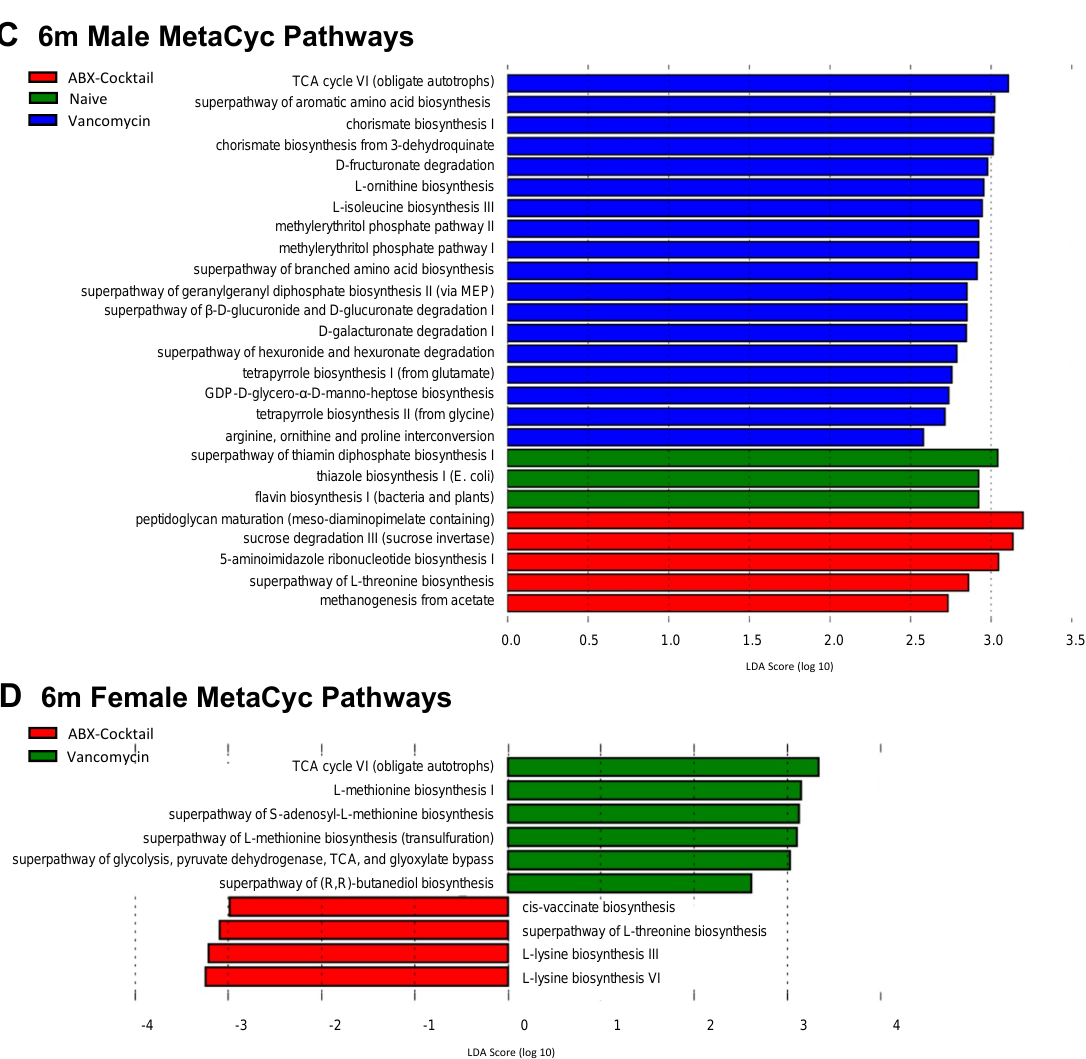
Figure 5. PICRUSt predictions of metabolic pathways. Functional summary for MetaCyc pathways, Linear discriminant analysis (LDA) effect size (LEfSe) analysis revealed significant bacterial differ- ences in gut microbiota between the antibiotic-treated groups and naive group from ( A ) p21 male, ( B ) p21 female, ( C ) 6m male, and ( D ) 6m female. LDA scores (log10)> 2 and p < 0.05 are shown. When all three groups are present: naive = green, vancomycin = blue, and ABX-cocktail = red. Otherwise, they correspond to their specific legend. The male n = 6 and female n = 6 for each